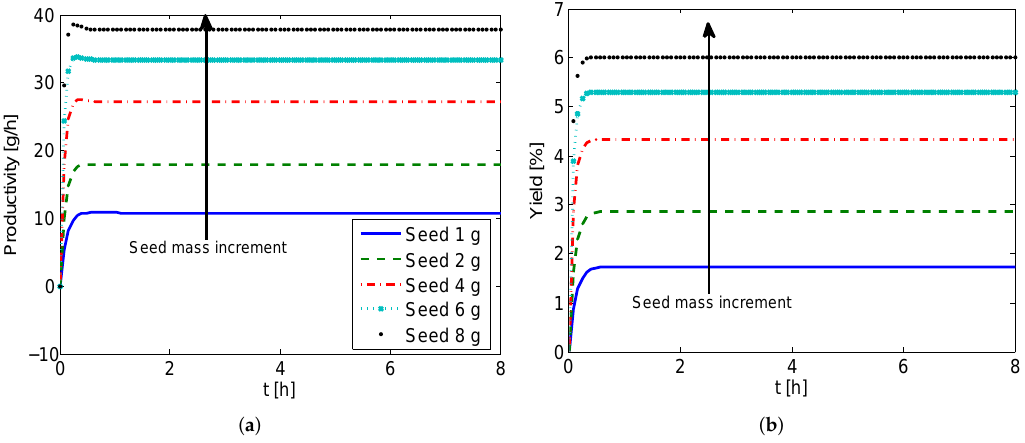
Figure 7. Simulation results showing the effect of seed mass on the productivity and yield of the coupled preferential crystallization in MSMPR crystallizers (CPC-MSMPR) (feed flow rate 80 mL min − 1 , exchange rate 80 mL min − 1 ). ( a ) Productivity increases with seed mass; ( b ) Yield increases with seed mass (for legend please refer to ( a